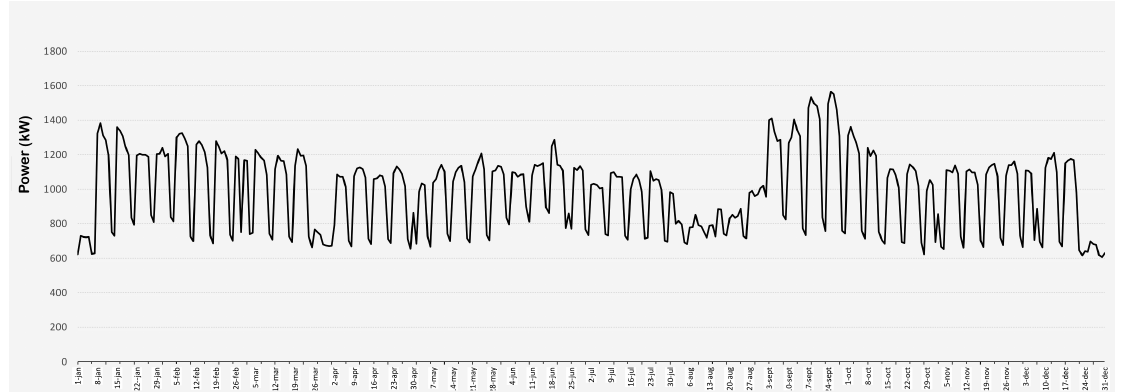
Figure 7. Average load curve of the university analyzed (year 2018).